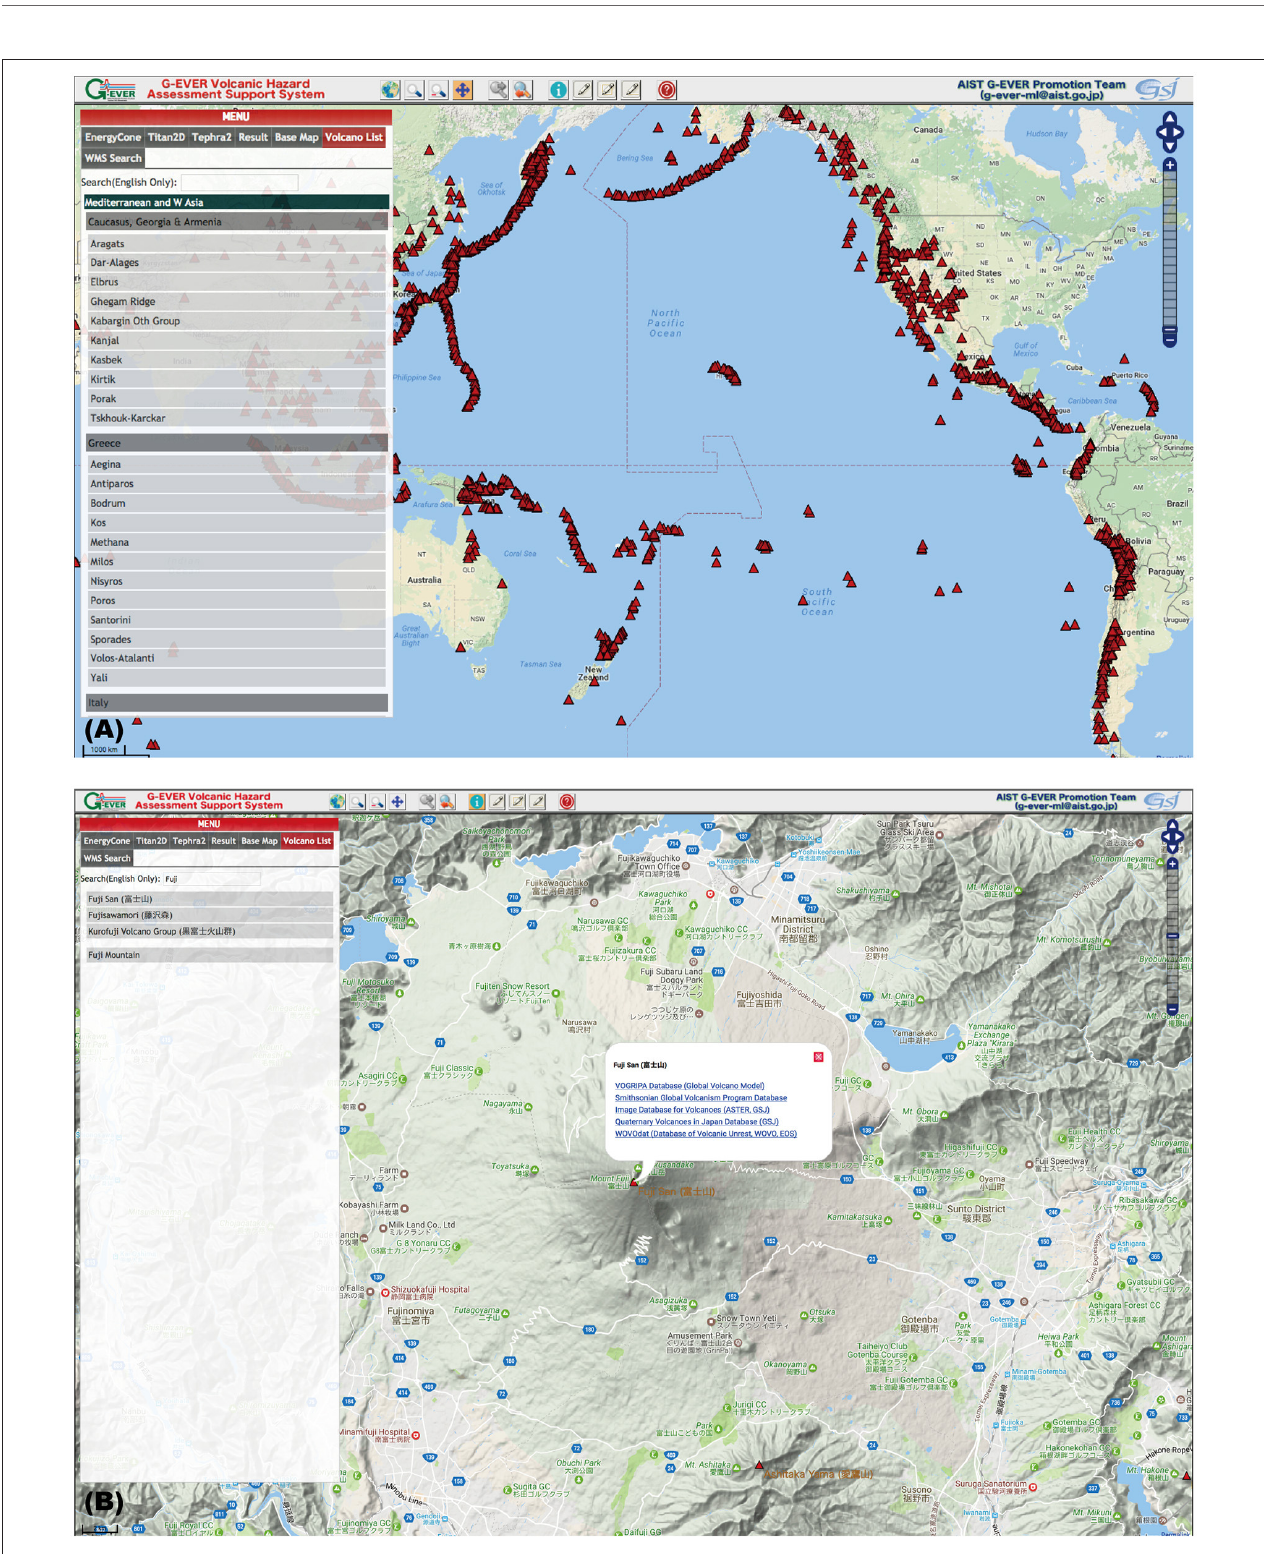
FIGURE 2 | Quaternary volcanoes search system. (A) Search menu on VHASS categorized by region. (B) Search system by volcano name and links to major volcano databases.